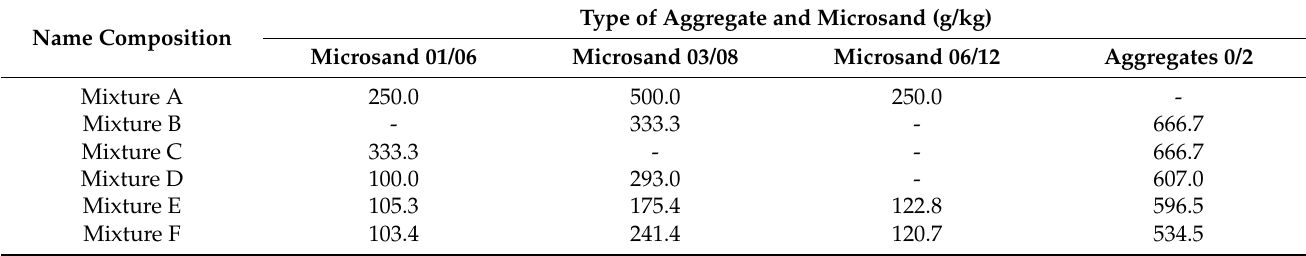
Table 3. Rations of aggregates and microsands used for each